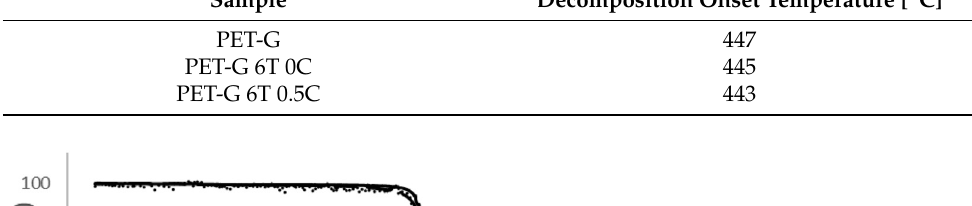
Figure 6. Graphical representation of TGA test results of PET-G and composite samples . Table 5. TGA test results of PET-G and composite samples .